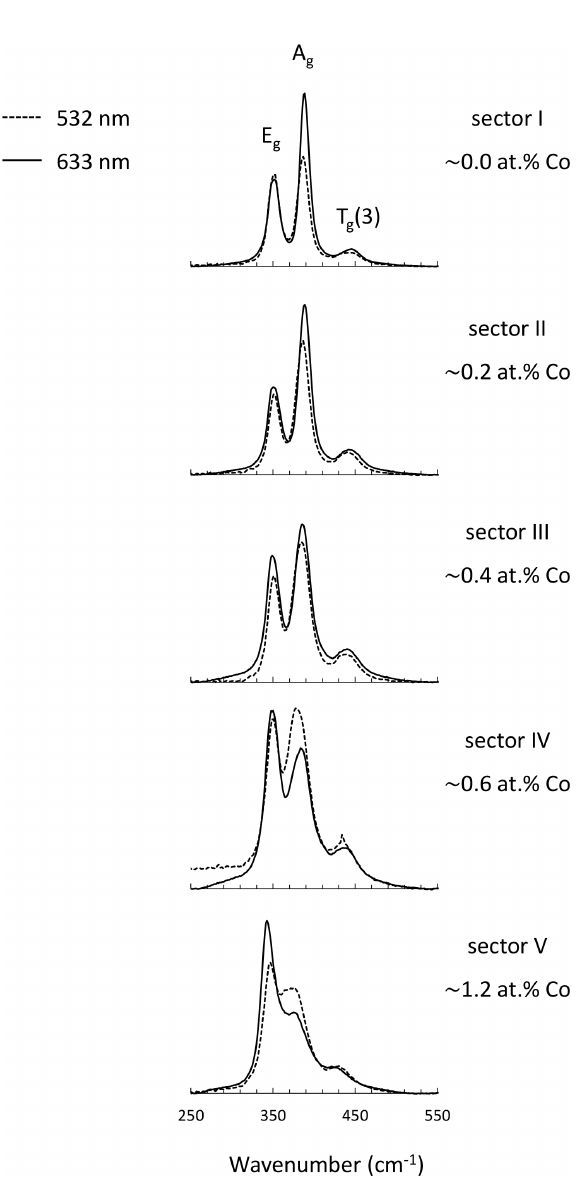
Figure 8. Raman spectra of pyrite with varying Co contents by 532 and 633nm